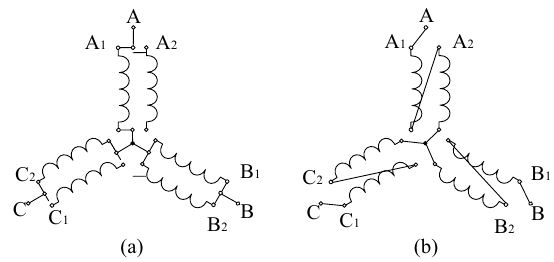
Figure 35 Winding connection methods: a Parallel and b